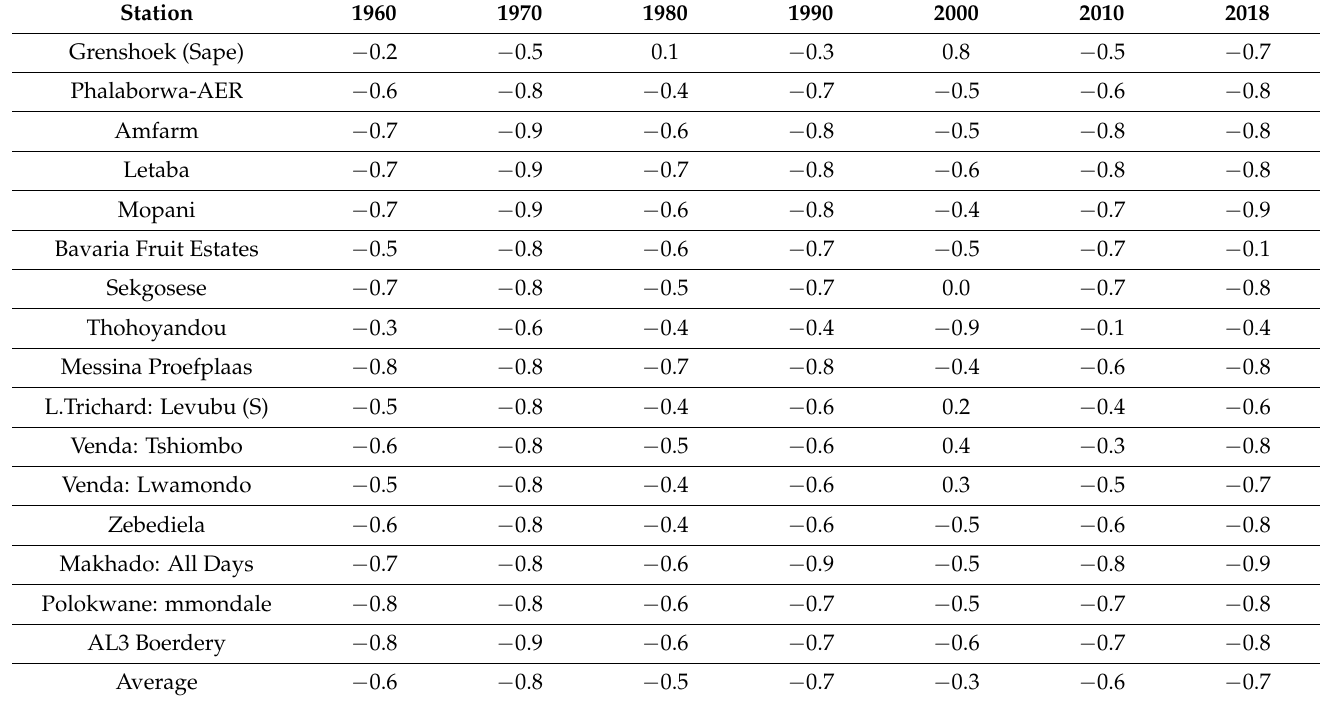
Table 7. Climatic Moisture Index ( CMI ) for the Mopani and Vhembe